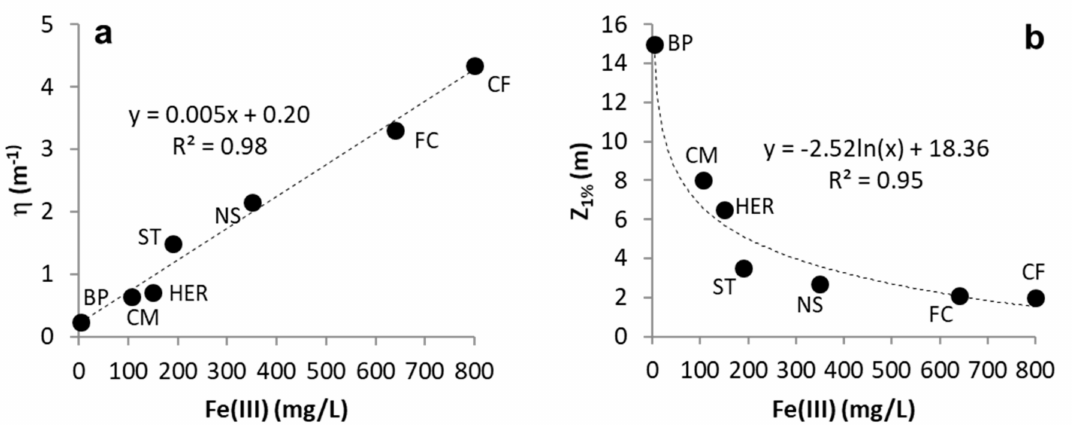
Figure 1. Binary plots showing dependence of light attenuation coe ffi cient ( η ) ( a ) and depth of 1% surface light (Z 1% ) ( b ) in di ff erent APL with respect to dissolved ferric iron concentration (Fe(III)). The regression lines (linear or exponential) and corresponding correlation coe ffi cients are indicated in both cases. The error bars (based on standard deviation of analytical Fe(III) determinations) lie within the same data points. Pit lake abbreviations: BP, Barruecopardo; CM, Cueva de la Mora; HER, Herrer í as;